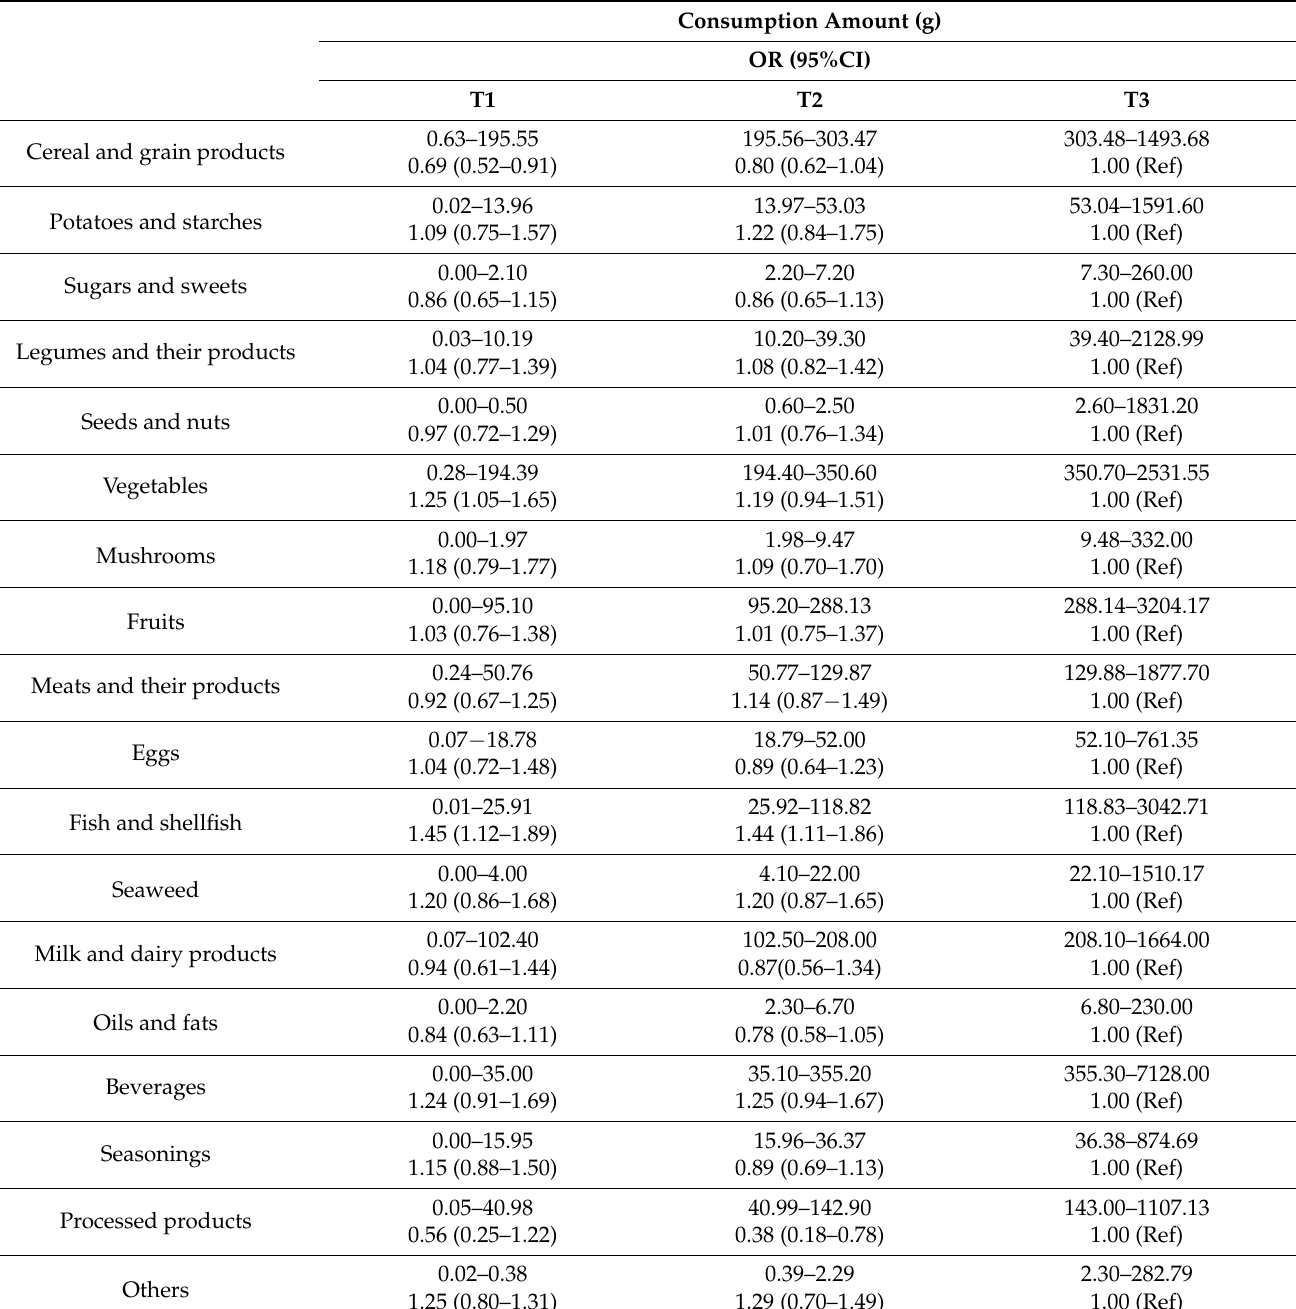
Table 4. Weighted odds ratios of a low HRQoL associated with tertile ranges of food group intake among Korean males ( n =